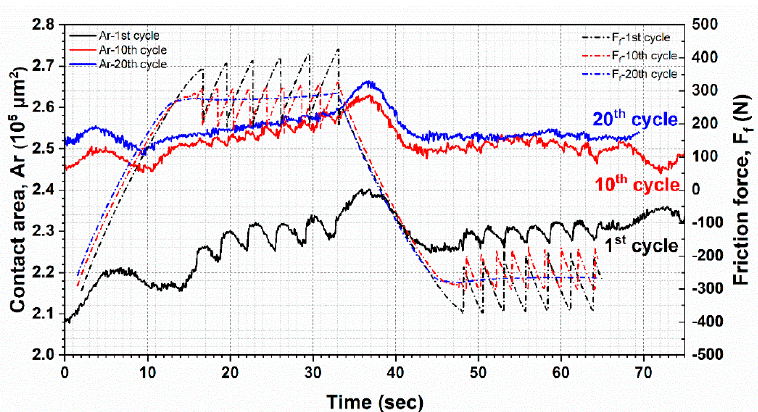
Figure 7. Change of contact area and friction force with time in the first (black), 10th (red), and 20th (blue) cycle from the test at 20 µm/s.